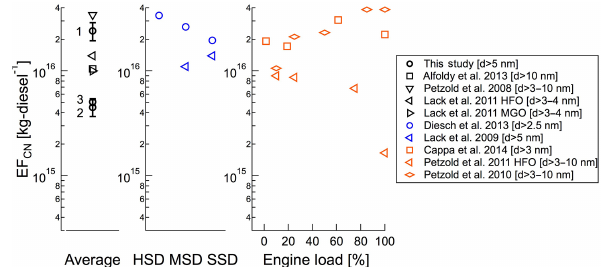
Figure 15. Emission factors for total particle count; fuel type (HFO: heavy fuel oil with high sulfur content, and MGO: marine gas oil with low sulfur content), or vessel class based on gross metric ton- nage (HSD: high speed diesel < 5000t, MSD: medium speed diesel 5000–30000t, or SSD: slow speed diesel > 50000t); plumes 1, 2, and 3 are indicated on the plot with numbers 1, 2, and 3 and the estimated uncertainty is shown by error bars.